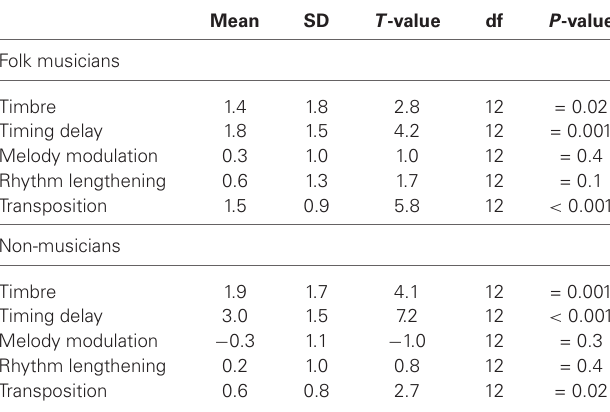
Table 3 | Two-tailed t -tests for verifying the significance of the P3a amplitudes against the zero baseline . Mean SD T -value df P